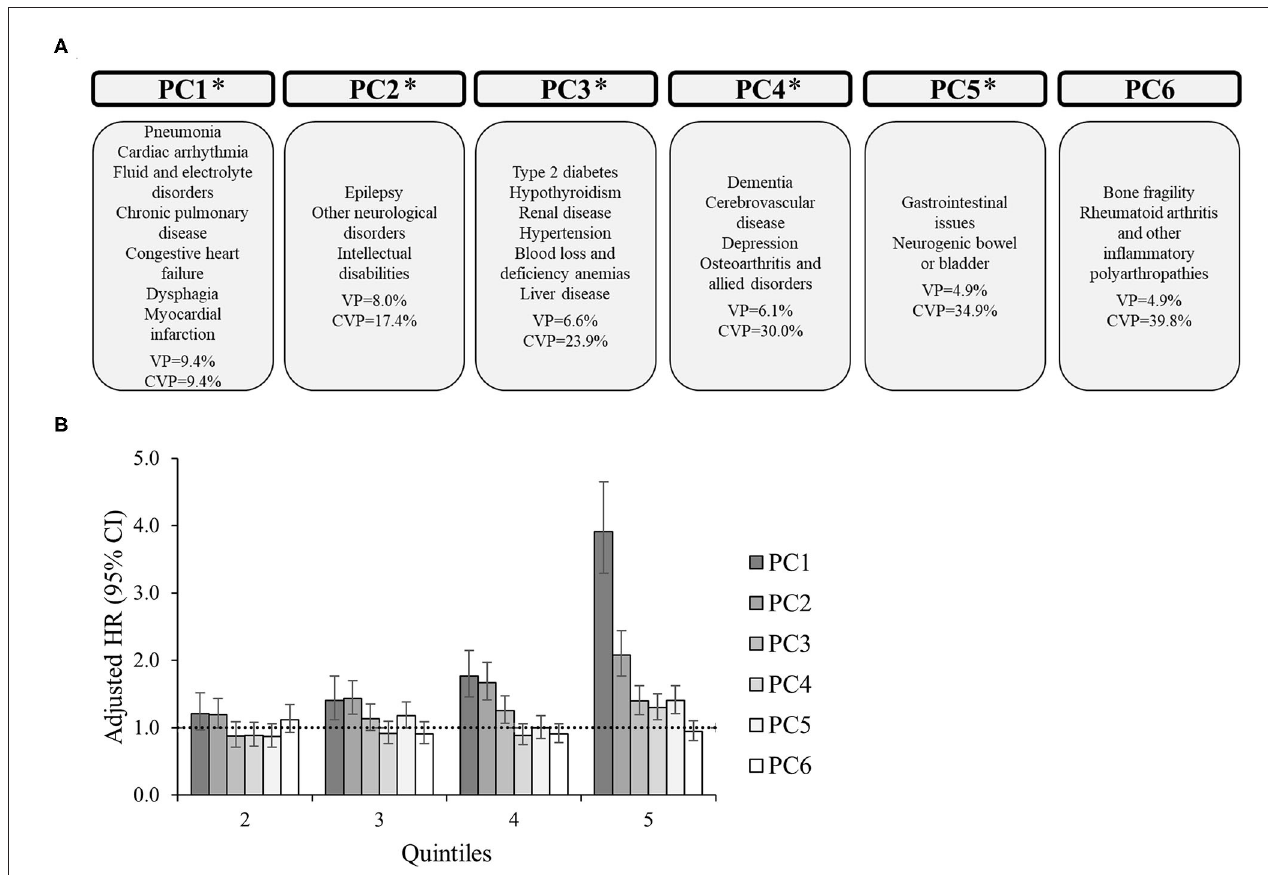
FIGURE 1 | Principal component analysis among 16,728 adults with cerebral palsy. (A) Principal components (PC) represent the comorbidity combinations in order of the amount of variance percent (VP) explained and the cumulative VP (CVP) explained. * P < 0.05 for the association of that PC with 2-year mortality. (B) The association between each PC with 2-year mortality after PC scores were transformed into quintiles to facilitate comparisons across PCs (reference: lowest quintile). The bars represent the hazard ratio (HR) and the vertical lines represent the 95% confidence interval (CI) for 2-year mortality after adjusting for all PCs, age, sex, race, and U.S. region of residence. The dotted horizontal line represents a HR of 1.0. If the 95% CI crosses the dotted line, the association is not statistically significant at P =